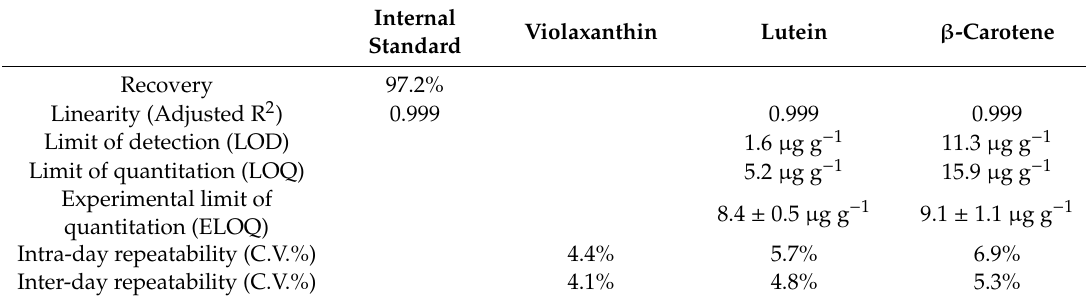
Table 1. Figure of merit of the optimized method (intra-day repeatability, n = 6; inter-day repeatability n = 3 × 3; limits are expressed as µ g g − 1 of sample on dry weight